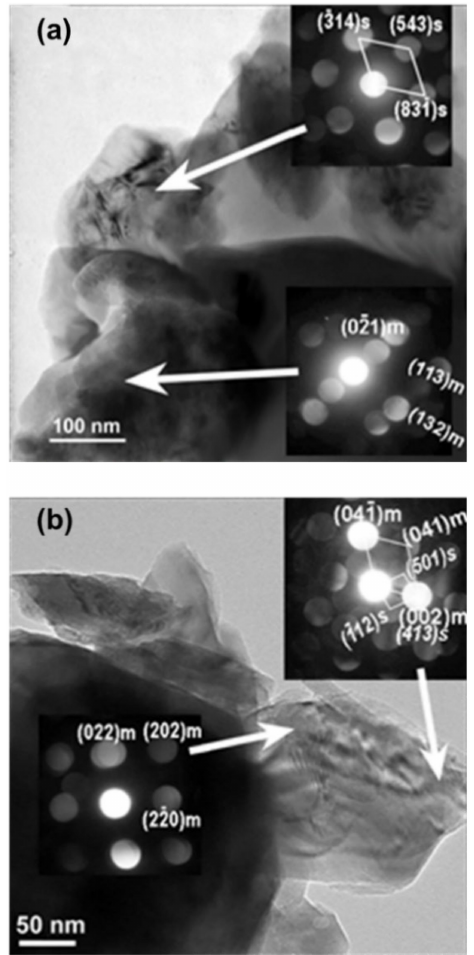
Figure 8. ( a ) TEM micrograph of Li 2 MnO 3 electrode after the first charge / discharge cycle at 0 ◦ C. The inserts show CBED patterns, which were taken from grains indicated by arrows. The pattern in the bottom insert is indexed on the basis of the monoclinic Li 2 MnO 3 phase (m), and the pattern in the upper insert demonstrates the presence of the tetragonal spinel Li 2 Mn 2 O 4 (s). ( b ) TEM micrograph of Li 2 MnO 3 electrode after the first charge / discharge cycle at 30 ◦ C. The inserts show CBED patterns taken from grains indicated by arrows. The bottom pattern is indexed to the monoclinic Li 2 MnO 3 phase (labeled m), and the pattern in the upper insert contains two systems of reflections related to the monoclinic phase (m) and to the tetragonal spinel